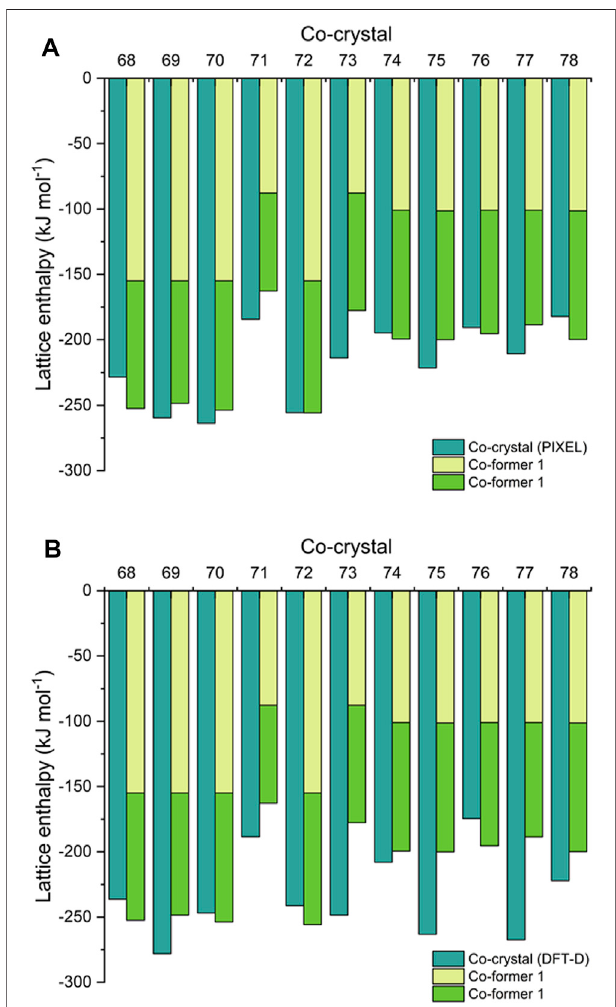
FIGURE 4 | Comparison of calculated lattice enthalpies of co-crystals 68 – 78 by (A) PIXEL and (B) DFT-D, alongside constituent co-formers.